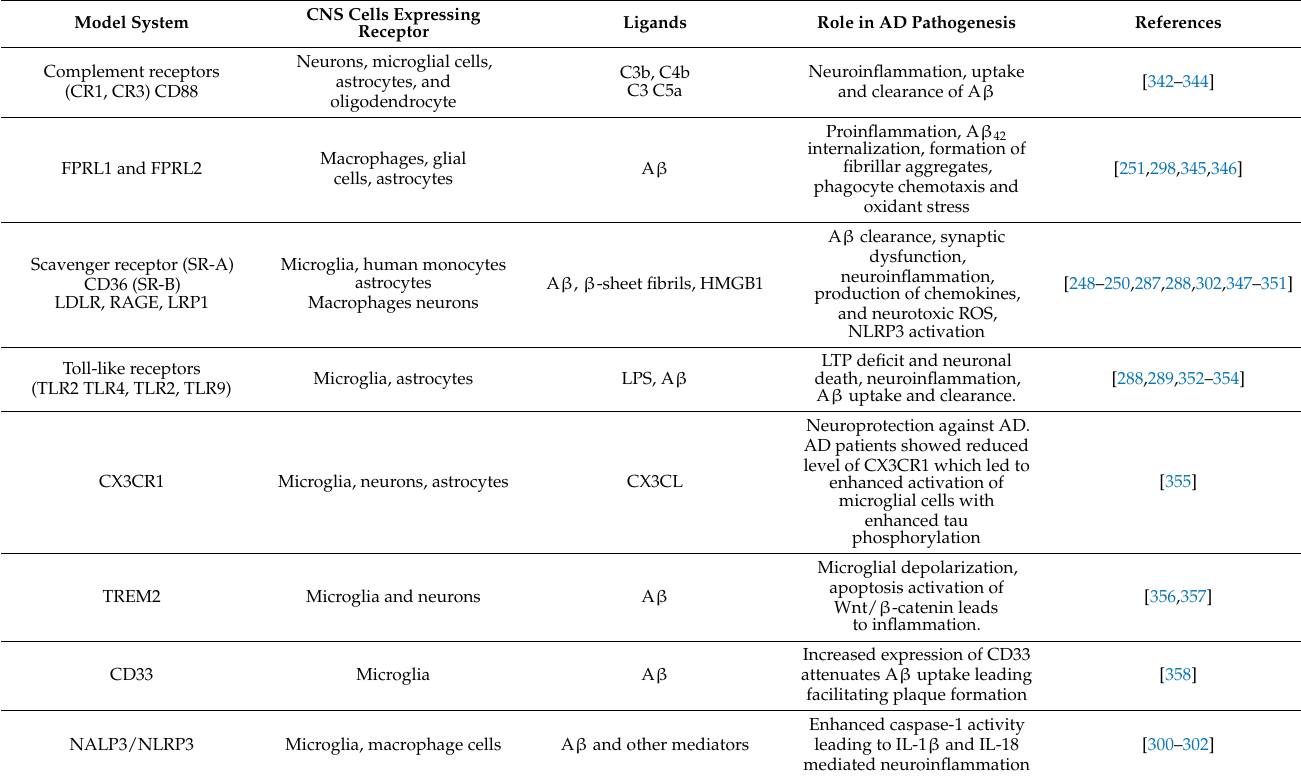
Table 1. Receptors associated with inflammatory response in